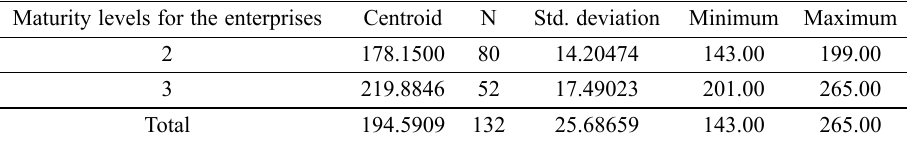
Table 5. Centroids by maturity levels for the enterprises